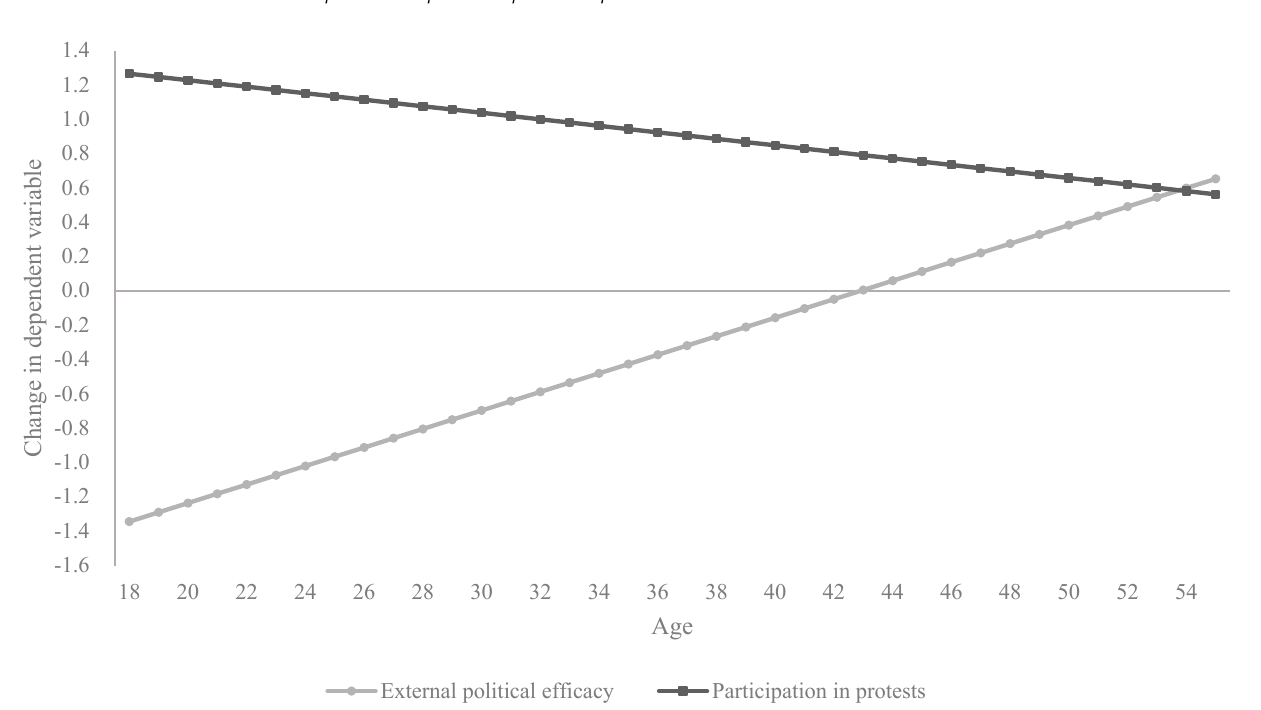
Figure 1. Change in dependent variable as a function of overeducation and age. Calculations made from coefficients in DRM models with interactions (Table 4).